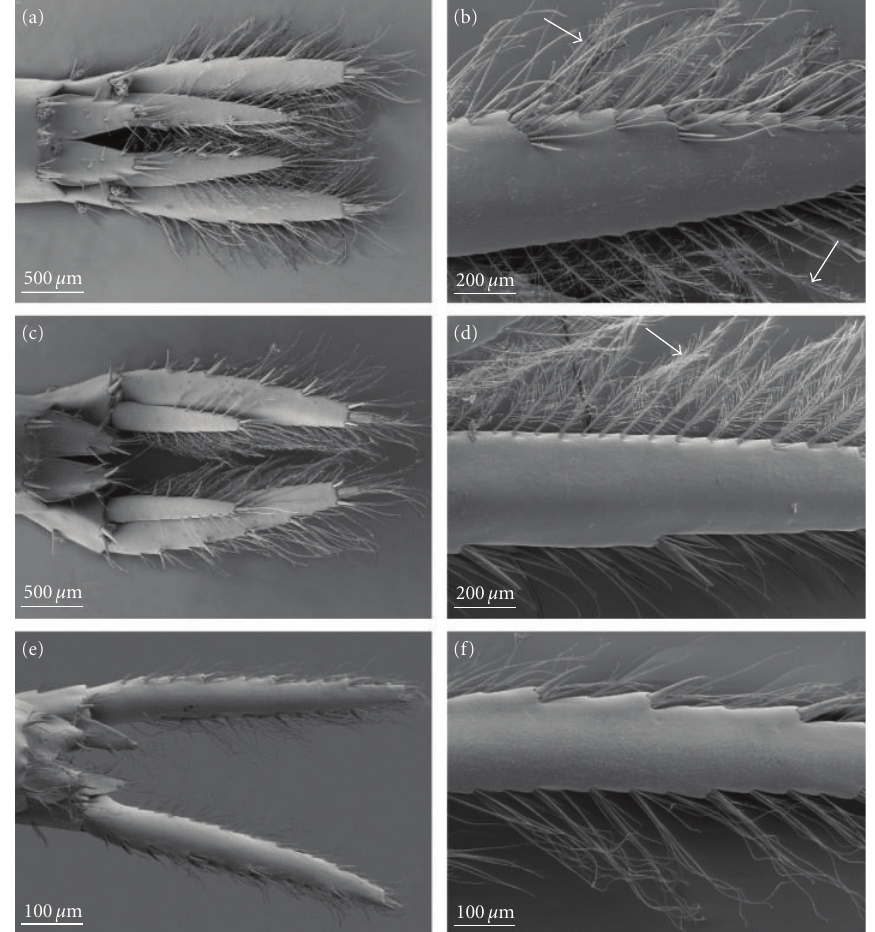
Figure 3: SEM images of telson and third uropods: (a) telson and third pair of uropods of G. pulex in situ in dorsal view; (b) exopod of left third uropod of G. pulex in anterior view; (c) telson and third pair of uropods of G. fossarum in situ in dorsal view; (d) exopod of left third uropod of G. fossarum in posterior view; (e) telson and third pair of uropods of E. berilloni in situ in dorsal view; (f) exopod of left third uropod of E. berilloni in anterior view. Arrows indicate presence or absence of plumose